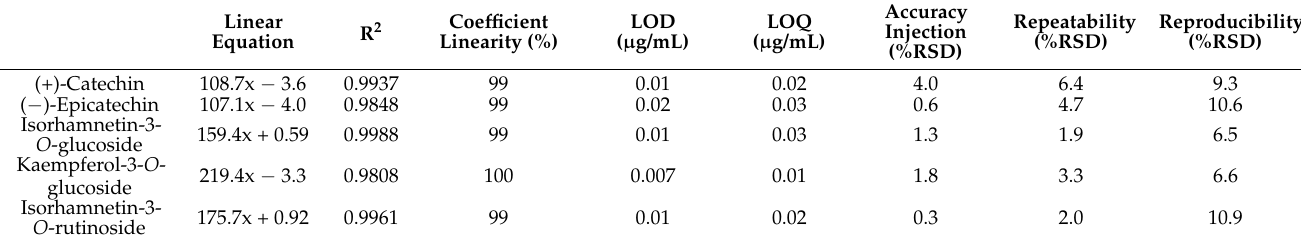
Table 4. Validation parameters in HPLC flavonoid determination.